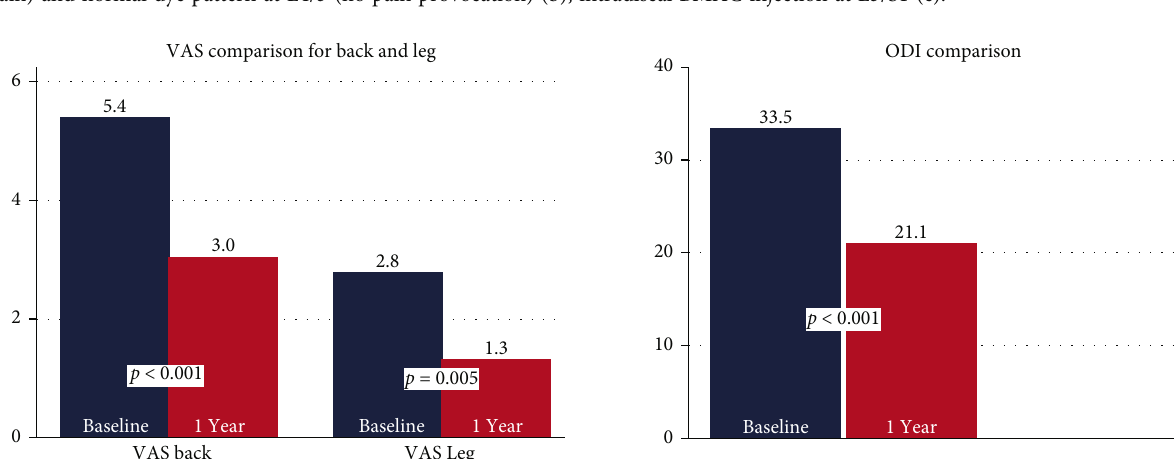
Figure 3: Bar graph comparing mean ODI scores at baseline and 1